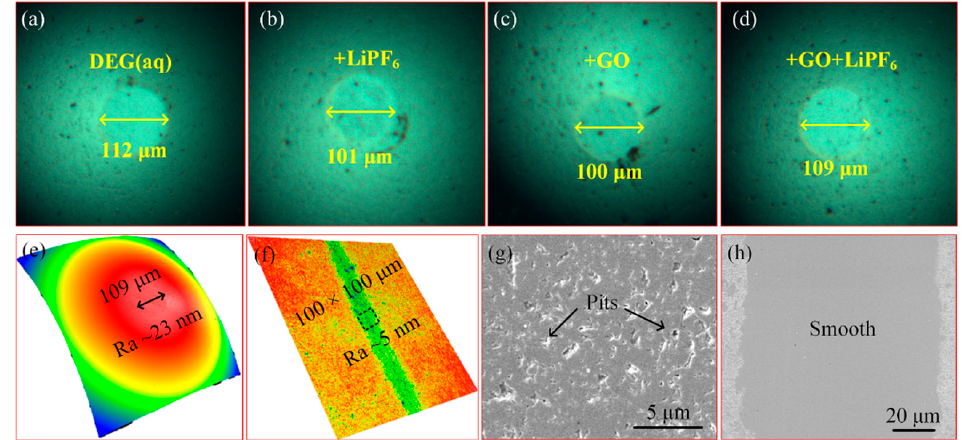
Figure 5. ( a – d ) WSDs of the balls: ( a ) DEG(aq), ( b ) +LiPF 6 , ( c ) +GO, and ( d ) +GO + LiPF 6 ; ( e , f ) worn area Ra lubricated with DEG(aq) + GO + LiPF 6 obtained by a white − light interferometer: ( e ) ball and ( f ) disk; ( g , h ) topographies of worn areas lubricated with DEG(aq) + GO + LiPF 6 obtained by SEM: ( g ) ball and ( h ) disk. The worn area was obtained under the condition of 3 N, 100 mm/s, and 20 μ L.